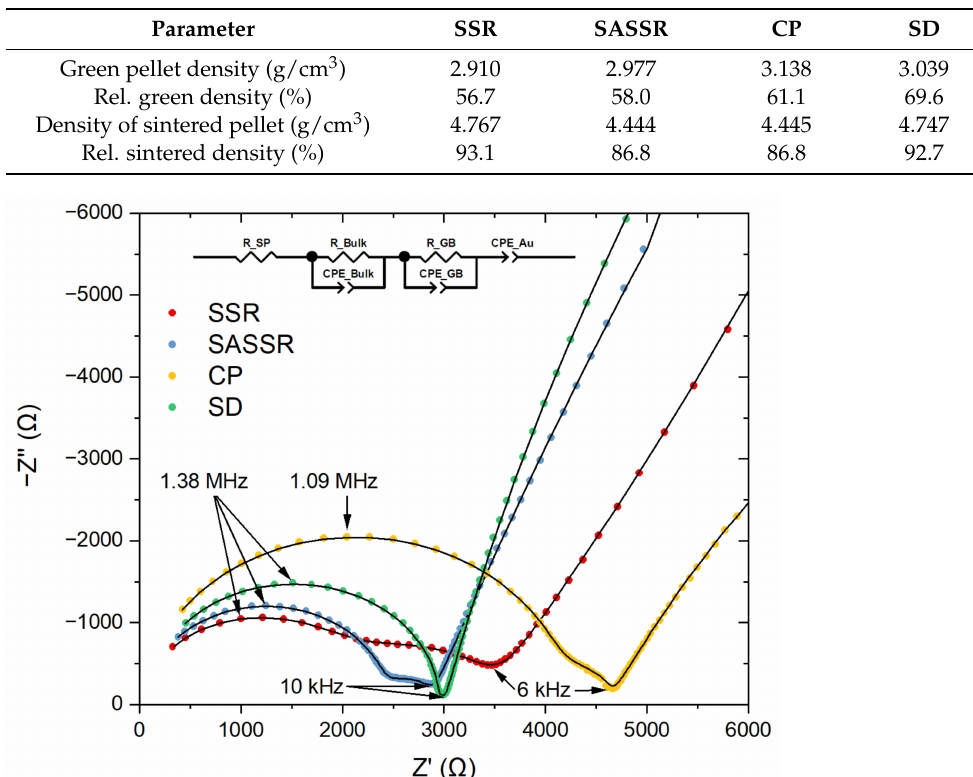
Figure 7. Scanning electron micrographs of cross-sections of polished, sintered pellets. ( a ) SSR, ( b ) SASSR, ( c ) CP, ( d ) SD. The pellets of SSR and SD show dense pellets with closed porosity, while SASSR and CP have a more open porosity, which is reflected in the lower relative density of just 87%. Impurities of Li 2 ZrO 3 in the samples SASSR, CP, and SD are visible in slightly darker areas and marked with dashed circles. Table 3. Density of green and sintered samples prepared by different synthesis routes.